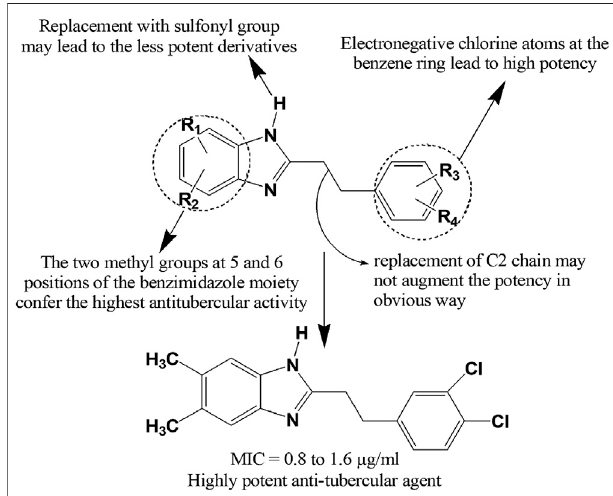
FIGURE 13 | Structure activity relationship (SAR) of benzimidazole derivatives having anti-tubercular effects. The fi gure represents the SAR studies accomplished by Gobis et al. (2015).